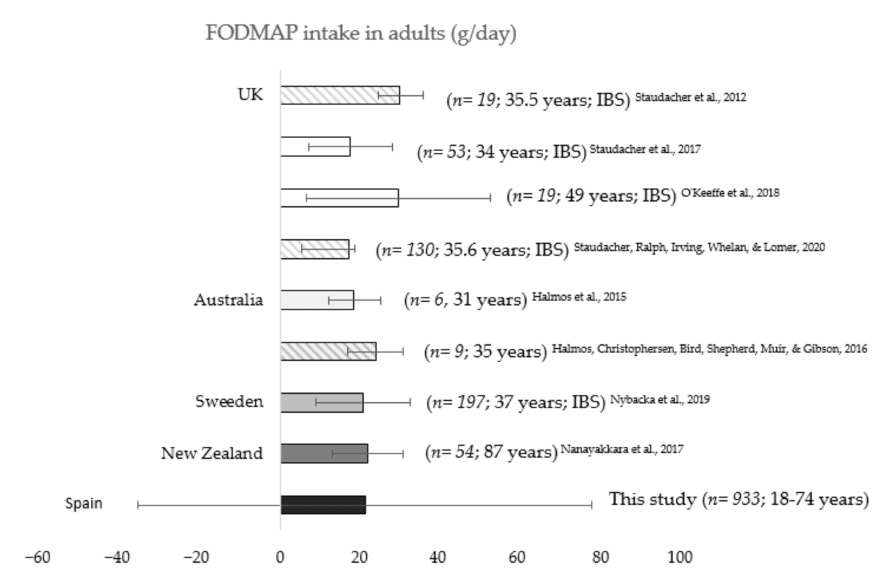
Figure 2. FODMAP intake of adult population in di ff erent countries ( n ; age; pathology). Columns corresponding to each country are depicted in di ff erent background color. Error bars in striped columns show a 95% confidence interval and those in plain columns show the standard